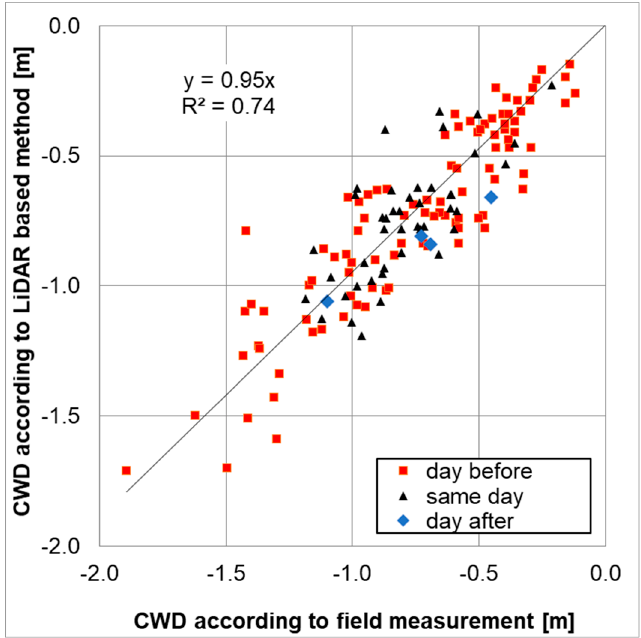
Figure 5. Validation of CWD as derived from LiDAR with field measurements in 2017 and 2018, conducted on the same day (plus/minus one day), for validation areas in eastern Sumatra and West Kalimantan. The trendline resulting in an R 2 value of 0.74 was forced through zero.